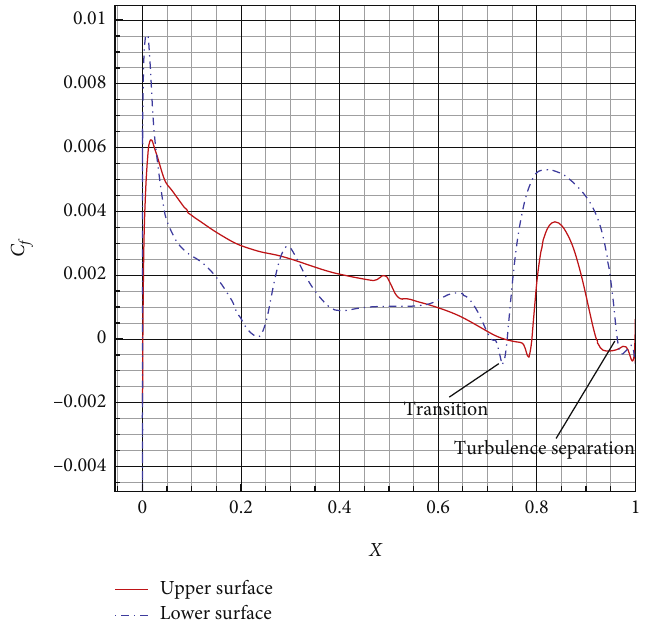
Figure 27: Skin friction distribution of DBLN-526 airfoil ( Re = 0 : 8 E 6 , α = 0 ° ).